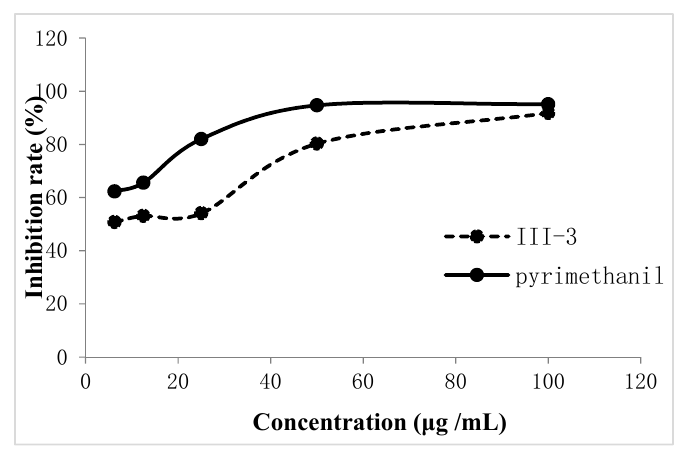
Figure 5. Effect of compound III-3 on the spore germination of B cinerea .